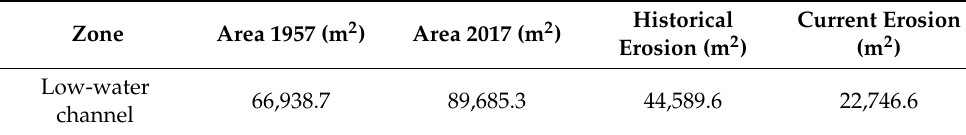
Figure 9. Diagram of fluvial dynamics analysis: ( A ).American flight photo; ( B ).Study sections; ( C ).Orto-photo 2017. Table 3. Changes present in the low-water channel,